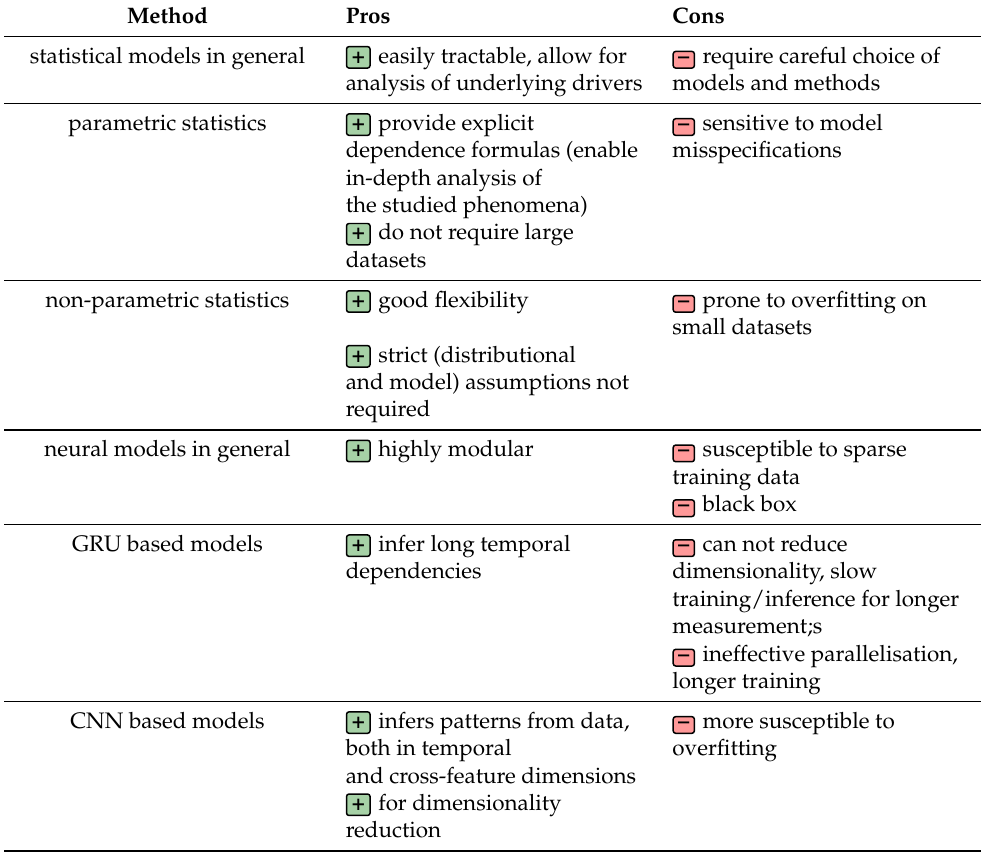
Table 8. Pros and cons of observed